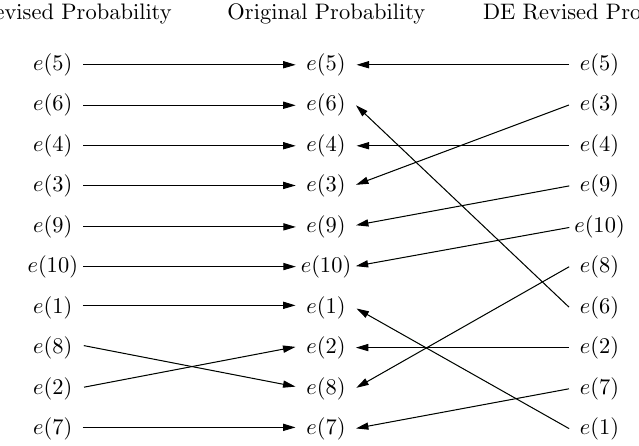
Figure 4: Comparison of expected impact ranking order for the 10 × 10 system.